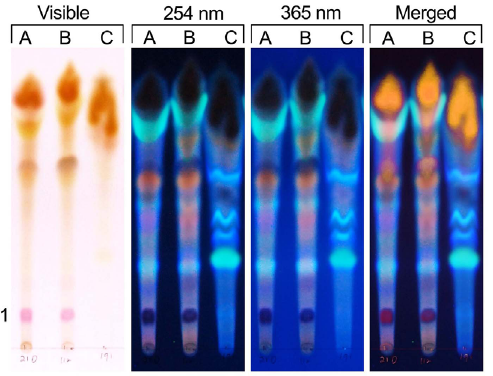
Figure 5. Extracted pigments and fluorescent compounds of Cryptococcus using large volumes of methanol. The methanol extracted pigments and fluorescent compounds of C. neoformans var. neoformans (column A), C. gattii , serotype B, (column B) and C. gattii, serotype C (NIH 191, column C). The pink water insoluble pigment (1) was produced by nearly all of the strains tested except for NIH 191, serotype C. The repeated methanol extracts removed most of the brown pigments. NIH 191 was selected because it shows considerable variations from many of the other strains. NIH 191 produced multiple fluorescent compounds that were not produced by most strains of C. gattii. The solvent system was 75% methanol, pH 7.00. doi:10.1371/journal.pone.0091901.g005 the same pink pigment is consistent with the laccase amino acid homology studies.